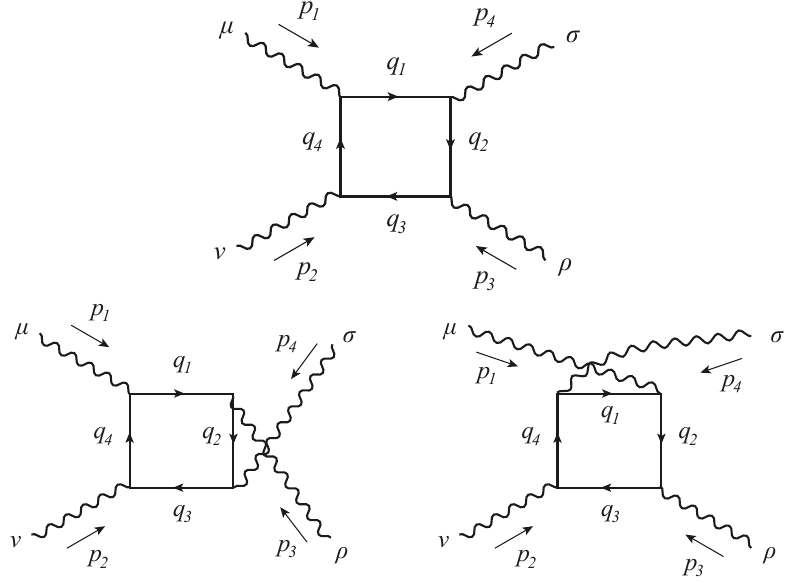
Figure 3 . The three box diagrams. Apart from the (cid:12)rst \box-1", we have to add the contribution from two more diagrams with p 3 ; (cid:26) $ p 4 ; (cid:27) (\box-2") and p 1 ; (cid:22) $ p 4 ; (cid:27) (\box-3")